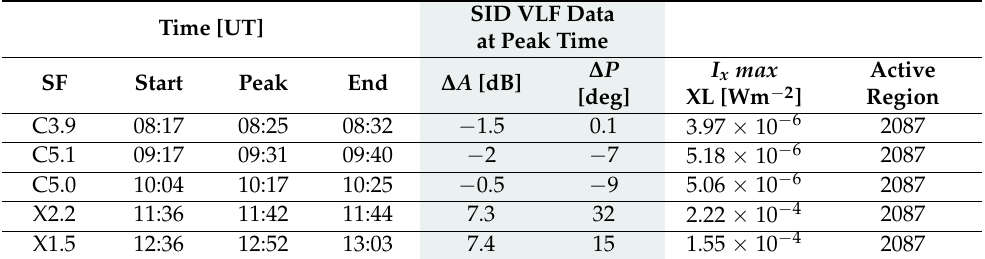
Table 1. Data of amplitude and phase perturbations of VLF signal induced by different SF events on 10 June 2014.